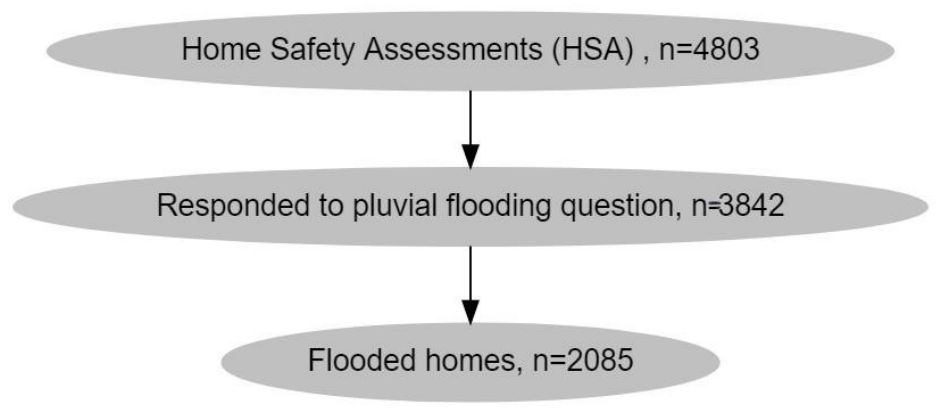
Figure 1. Flowchart of data collection.